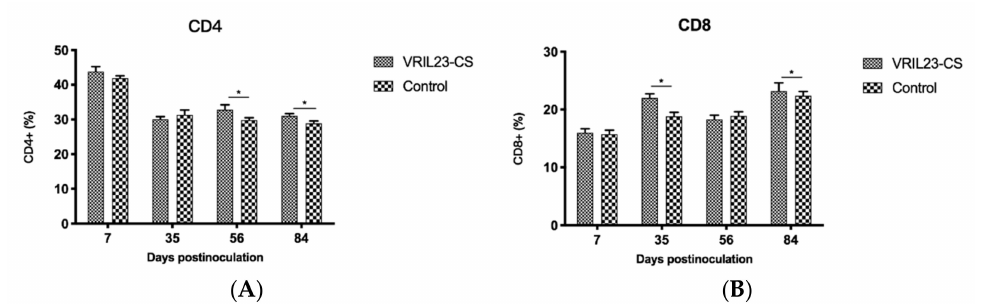
Figure 8. Changes of the CD4 + and CD8 + T cells in the blood of experimental pigs. ( A ) CD4; ( B ) CD8. * indicates the di ff erence between the two groups is significant, p <